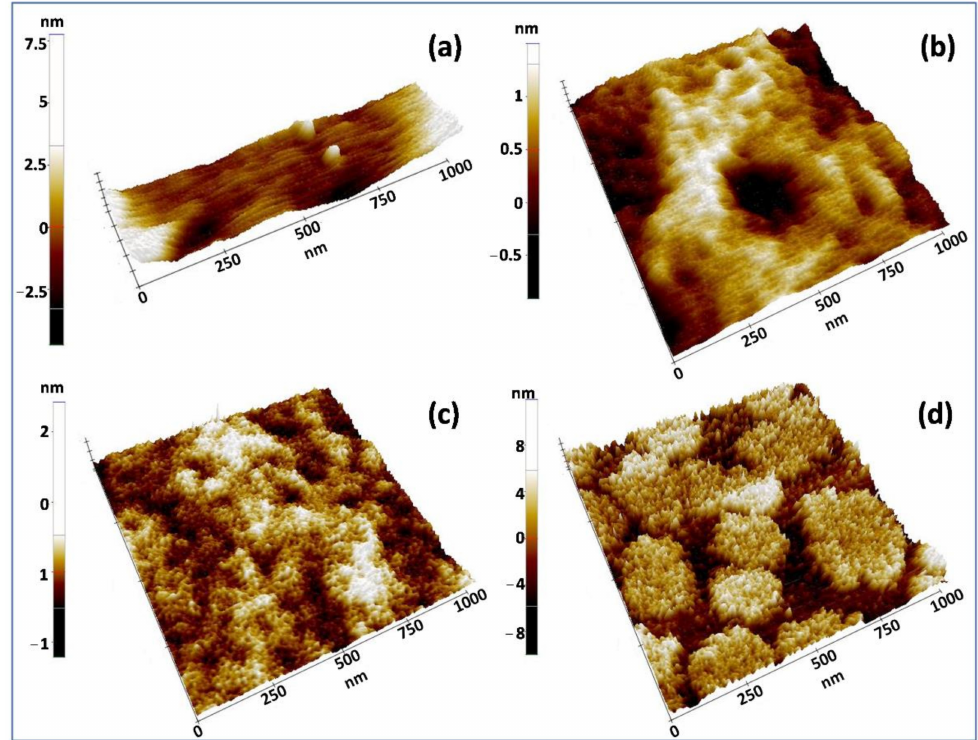
Figure 5. 3D Atomic Force Microscopy (AFM) images at the scale of (1 × 1) µ m 2 for the silica materials deposited as films onto PVC substrate. ( a ) uncoated PVC; ( b ) coated with TEOS/MTES/OTES (S1); ( c ) coated with TEOS/MTES/VTMES (S2); ( d ) coated with TEOS/MTES/HDTMES